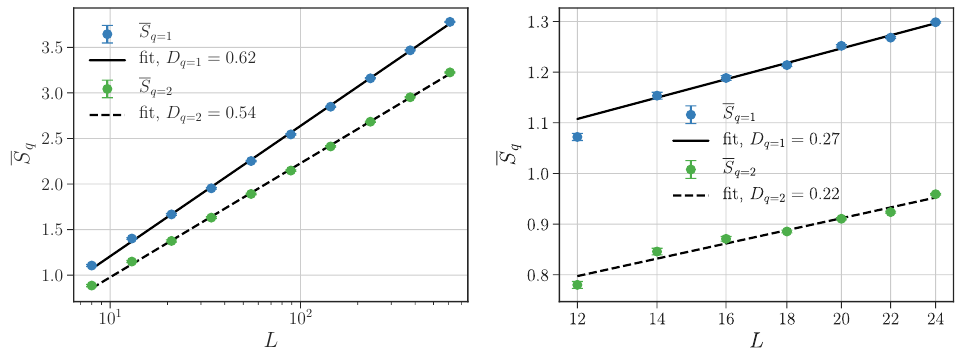
Figure 9: Scaling of the orbitals participation entropy S free (left panel) and interacting (right panel) Fibonacci chains, at h = 1.